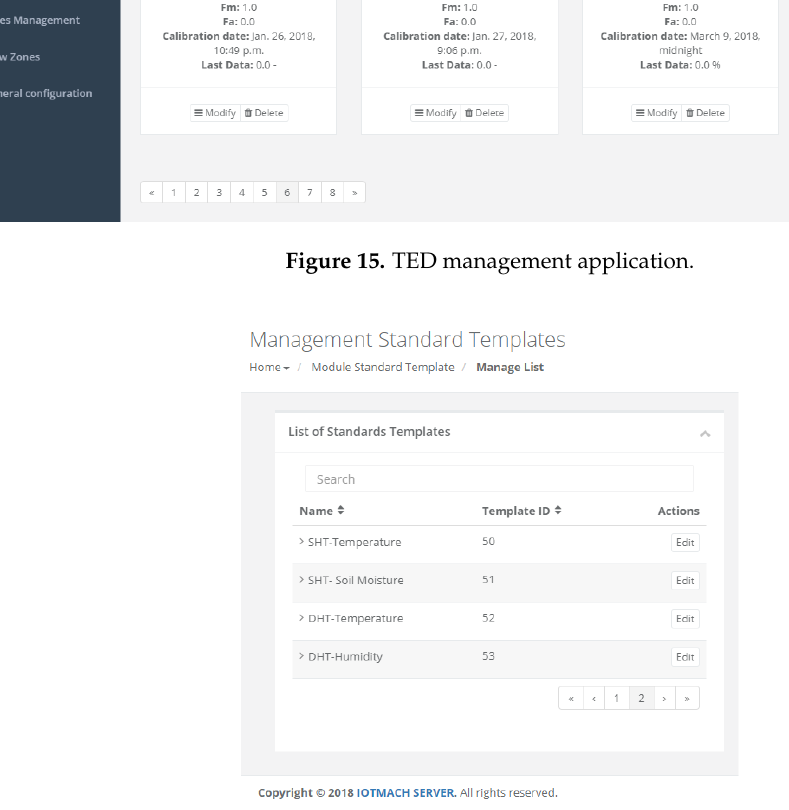
Figure 16. Standard template menu.